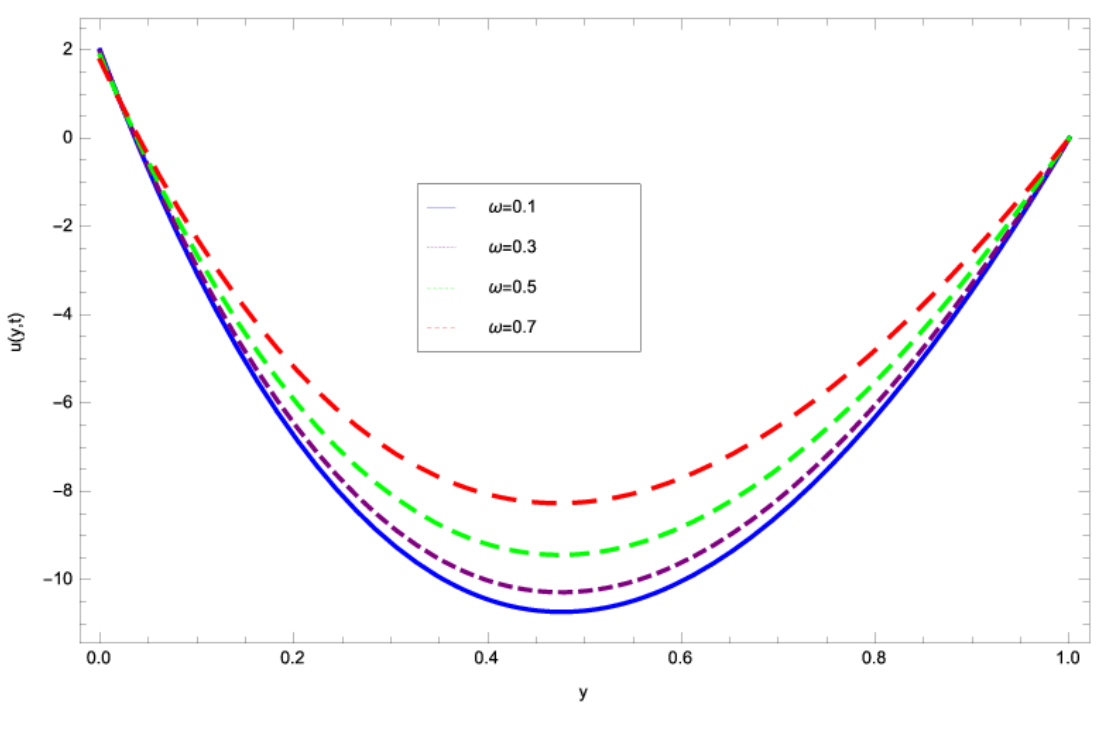
Figure 7. The effect of the oscillating parameter ω during fluid motion, when m = 0.5; W e = 5; 0 . 5 ; M = 1.6; t = 1. Appl. Sci. 2017 , 7 , 369